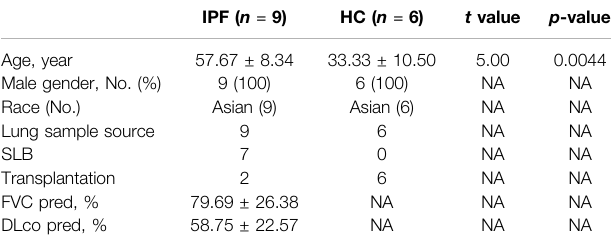
TABLE 1 | Characteristics of participants in mRNA-Seq study.